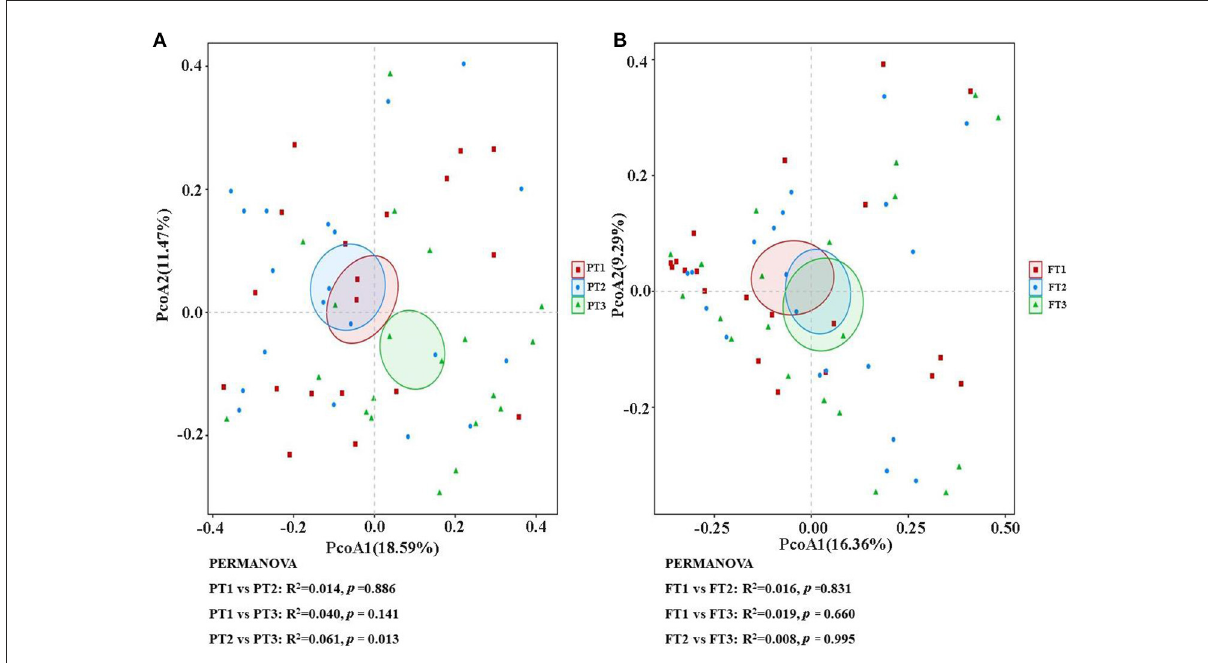
FIGURE5 The β -diversity analysis of the oral (A) and gut (B) microbiomes among different DII tertiles in patients with AD. The PCoA based on the Bray–Curtis of β -diversity analysis is presented. PCoA, principal coordinate